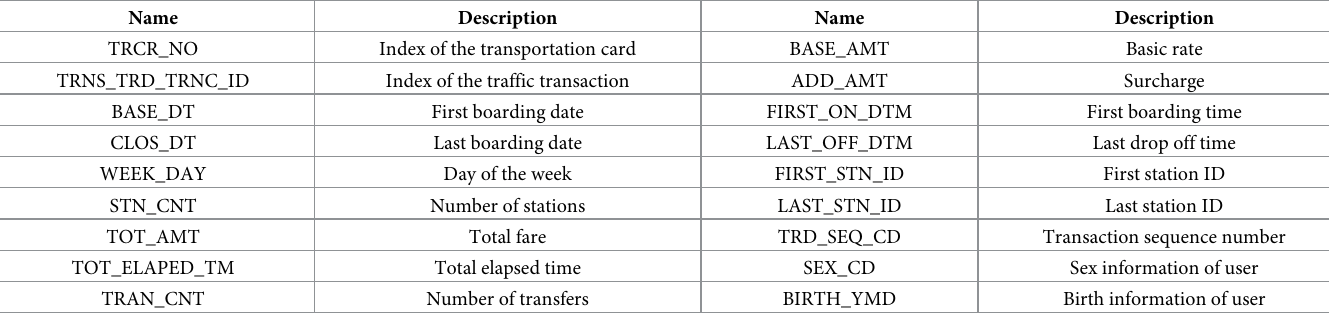
Table 1. Summary of the attributes of the collected